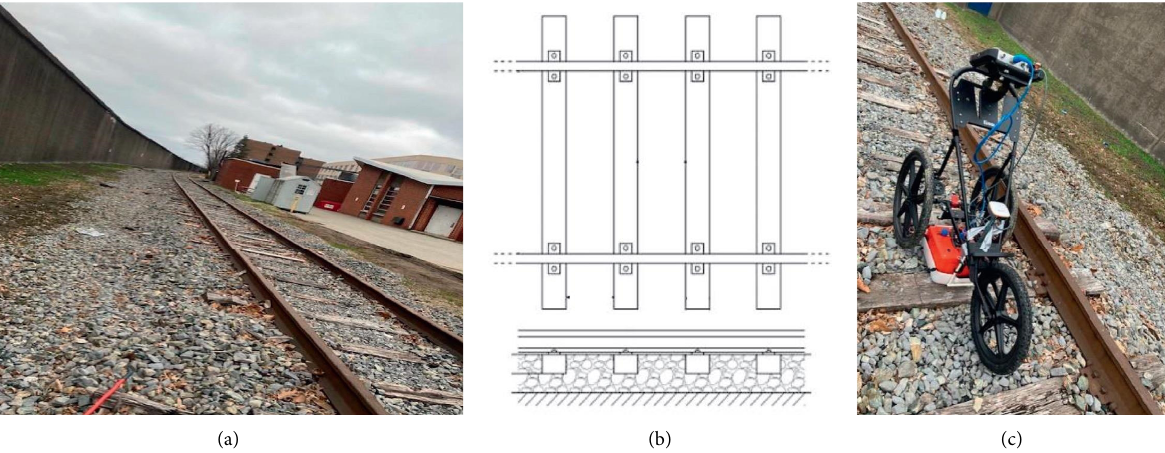
Figure 1: (a) Location of the test site. (b) Schematic characteristics of the railway. (c) Test equipment